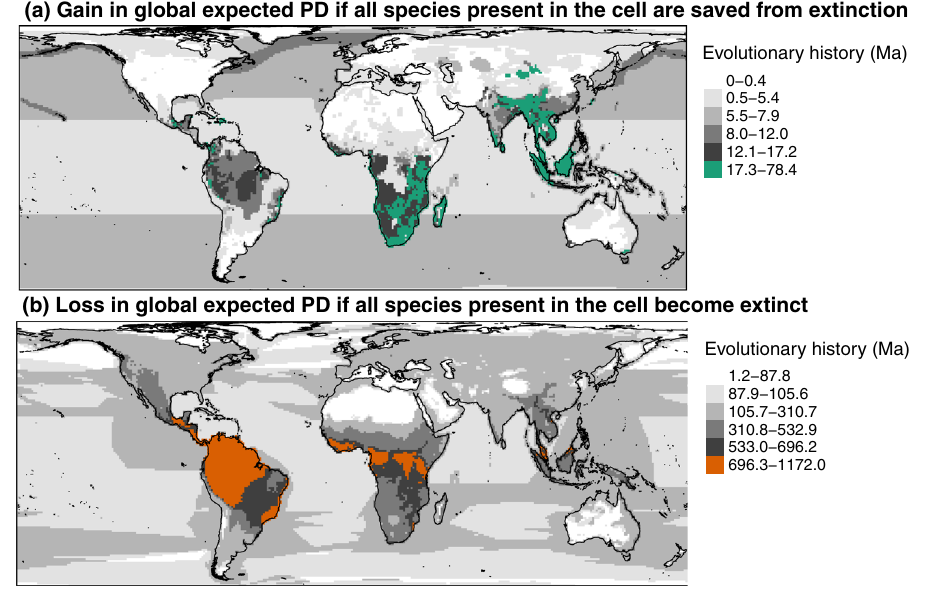
Fig. 4 Areas of interest for conserving global mammalian PD. Areas of interest for conserving global mammalian PD. Spatial patterns and hotspots of gain in global expected PD if all species present in the cell are saved from extinction ( p = 0) ( a ) and loss in global expected PD if all species present in the cell become extinct ( p = 1) ( b ). Hotspots, in colour, represent the 2.5% cells with the highest